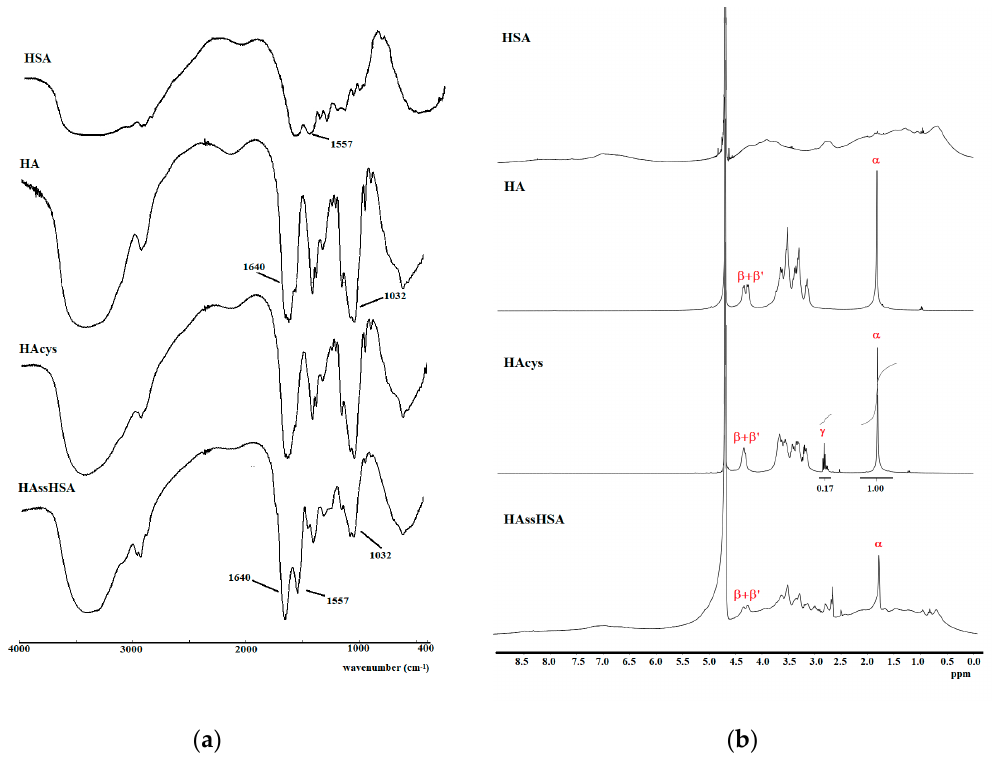
Figure 2. FT-IR ( a ) and 1 H-NMR ( b ) spectra of HSA, HA, HAcys and HAssHSA.